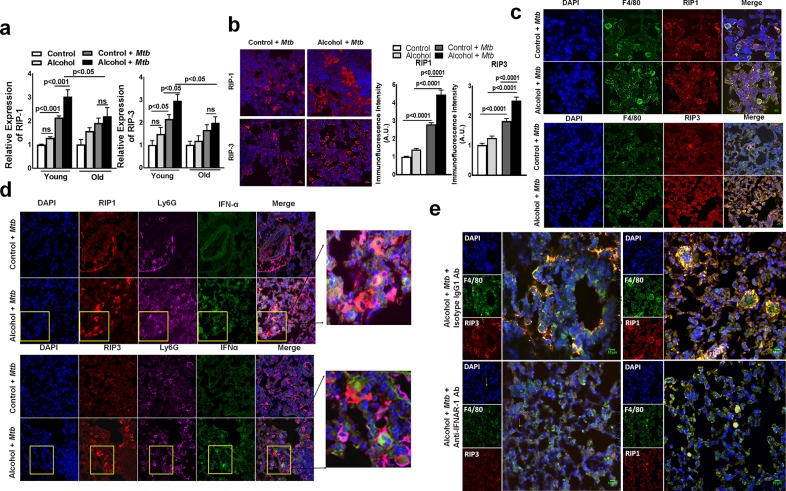
IFN-α production in Mtb-infected young alcoholic mice is associated with the expression of molecules involved in necroptosis.a. Young (one to two months of age) and old (17 to 22 months of age) mice were fed control and alcohol diets for one month as detailed in the methods section; then, they were infected with 50–100 CFU of aerosolized Mtb H37Rv, and control and alcohol diet feeding was continued. At six months p.i., lung homogenates from uninfected control and alcohol diet-fed mice and Mtb-infected control and alcohol diet-fed mice were collected, and RIP-1 and RIP-3 gene expression was determined by quantitative real-time PCR. Control and alcohol diet-fed young mice were infected with 50–100 CFU of aerosolized Mtb. At three months p.i., lungs from uninfected control and alcohol diet-fed mice as well as from Mtb-infected control and Mtb-infected alcohol diet-fed mice were isolated and formalin fixed. Paraffin-embedded tissue sections were prepared and analyzed by confocal microscopy for b. RIP-1+ and RIP-3+ cells (red). Representative images of staining patterns were taken of multiple fields at 40X and 63X with oil immersion. The immunofluorescence intensities for these groups were calculated. c. RIP-1- and RIP-3 (red)-expressing F4/80 macrophages (green). d. Lung paraffin-embedded tissue sections were analyzed by confocal microscopy to determine IFN-α (Green), Ly6G (Magenta or Far-red) and RIP1/3 (red) colocalization. Scale bar: 10 μm. The rightmost panel shows a higher magnification for representation, and the yellow squares represent IFN-α-expressing Ly6G+ cells. e. Representative images of RIP-1 and RIP-3 expression in lung F4/80 macrophages from anti-IFNAR-1 antibody-treated and isotype control antibody (IgG1)-treated mice are shown. Five mice per group were used for each group. The mean values, p-values and SEs are shown.